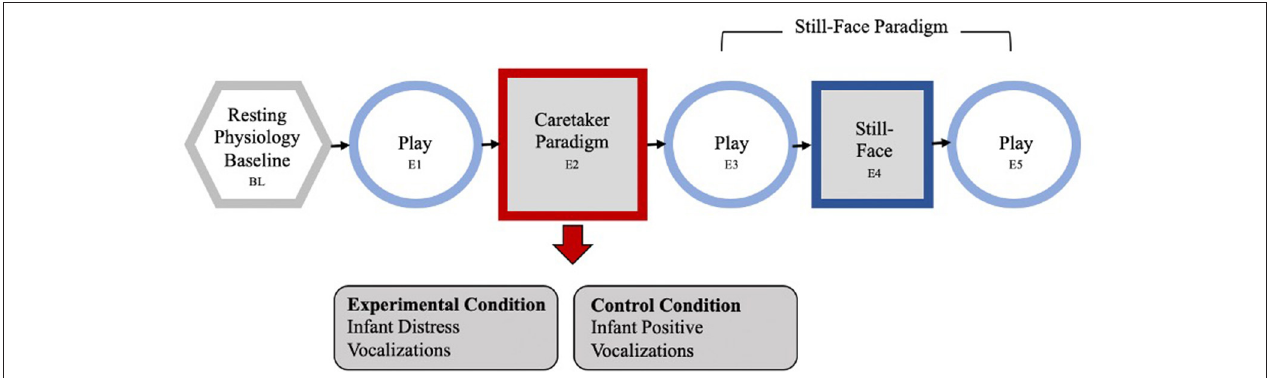
FIGURE 1 | The Caretaker Acute Stress Paradigm, containing a standard 30-s physiology baseline and 5 episodes, each 2min long. First the dyad engages in a face-to-face natural play (episode E1). The acute caretaker experimental episode (E2) follows: the caretaker is exposed to an auditory and matching visual stressor or control condition. Caretakers in the experimental condition hear infant cries, in the control condition mothers hear infant laughter and giggles over the earphones while watching matched images on a screen. Next, mother and infant were reunited for another face-to-face play episode (E3), followed by a classic still-face episode (E4) where the mother is asked to stop the interaction, sit back, and maintain a neutral “poker-face” (still-face). The final episode is another face-to-face play (E5).